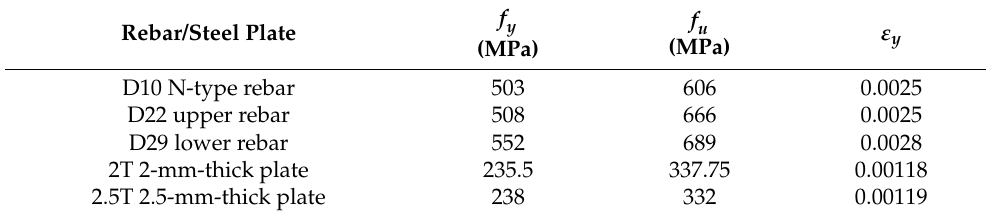
Table 3. Rebar and steel plate tensile test